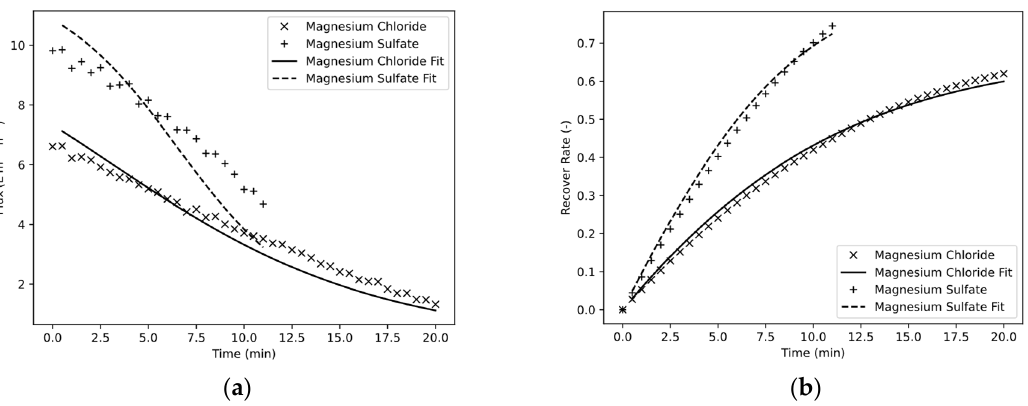
Figure 7. Water flux ( a ) and recovery rate of storage tank ( b ) as a function of time.